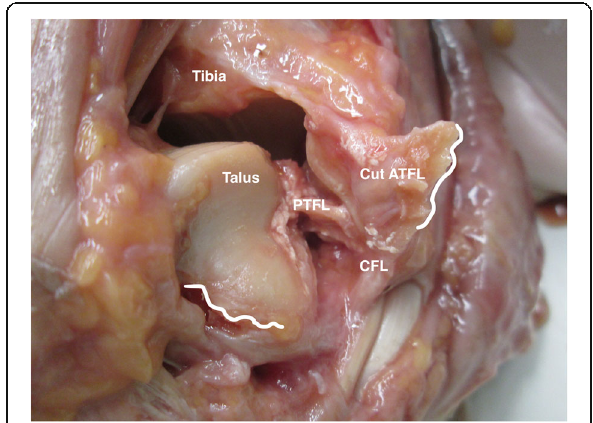
Fig. 1 Image of a cadaveric ankle after cutting the ATFL ligaments. The CFL and PTFL are still intact. The white lines show the original position of the ATFL insertion. The gravity stress is enough to show varus and internal rotation of the talus, in relation with the